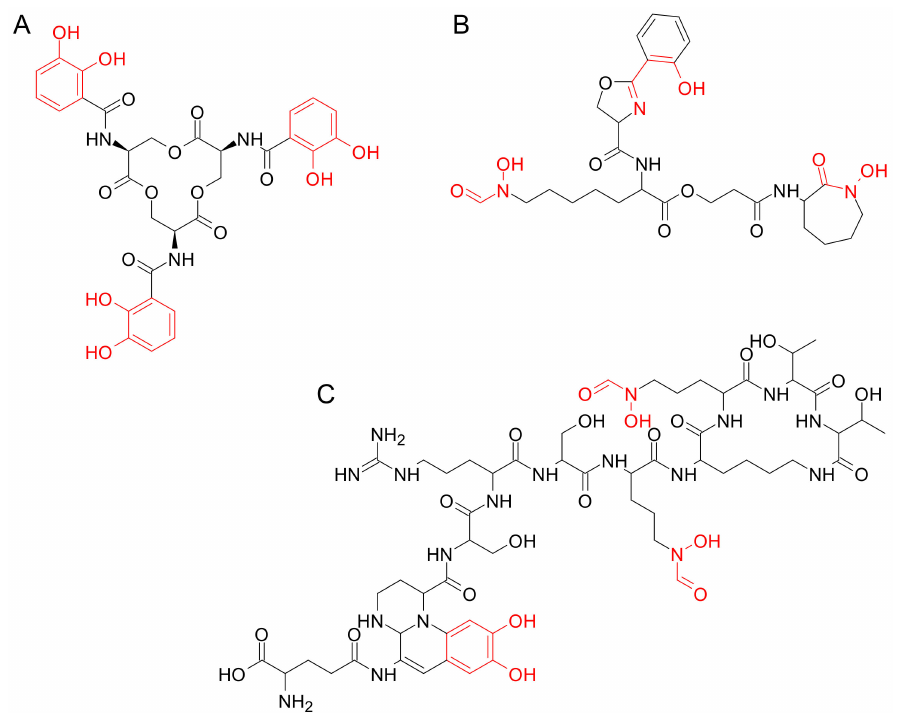
Figure 1. Chemical structures of representative siderophores: ( A ) catecholate enterobactin (PubChem CID:34231); ( B ) hydroxamate mycobactin (PubChem CID: 3083702); ( C ) mixed-type